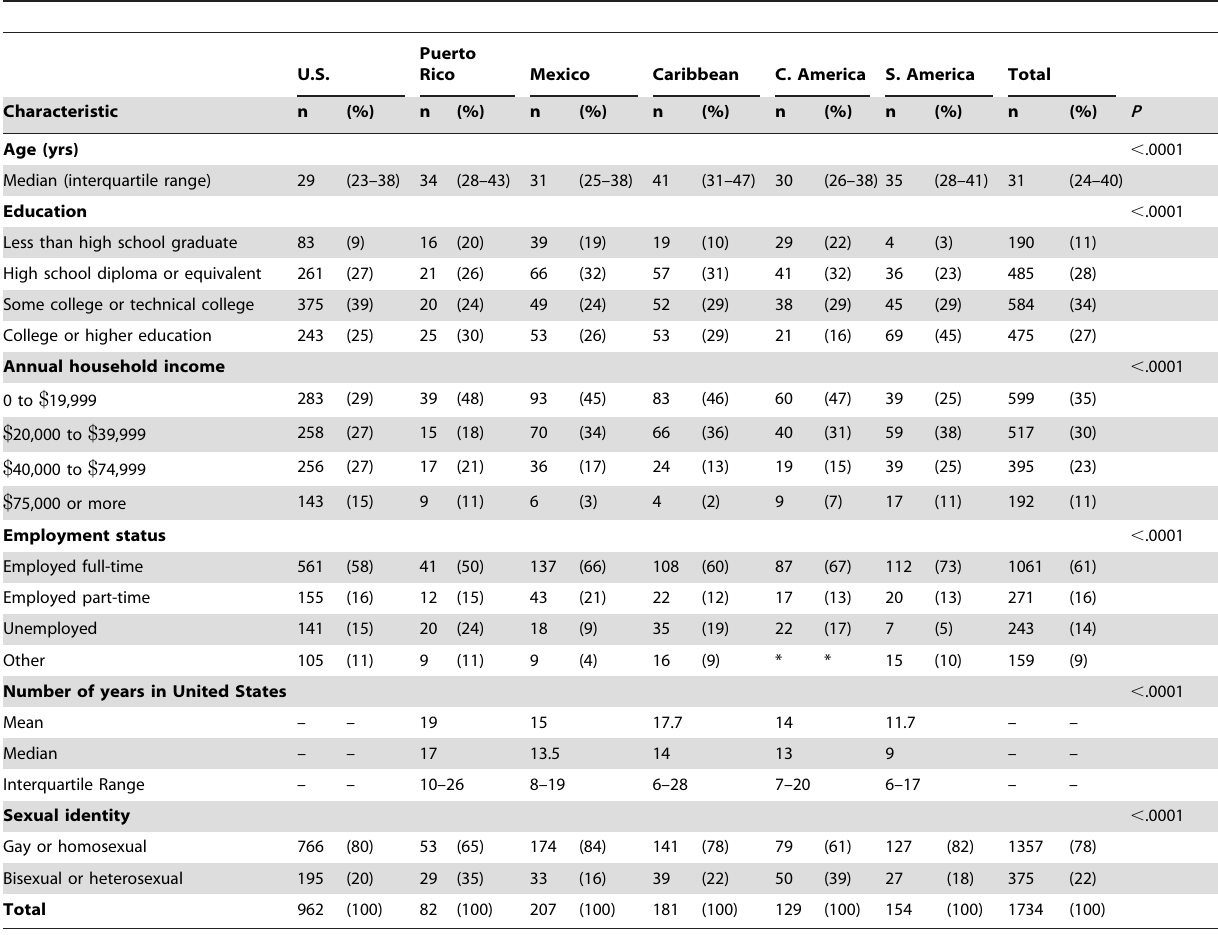
Table 1. Characteristics of Latino MSM by location of birth – 20 U.S. Cities, National HIV Behavioral Surveillance System, 2008.